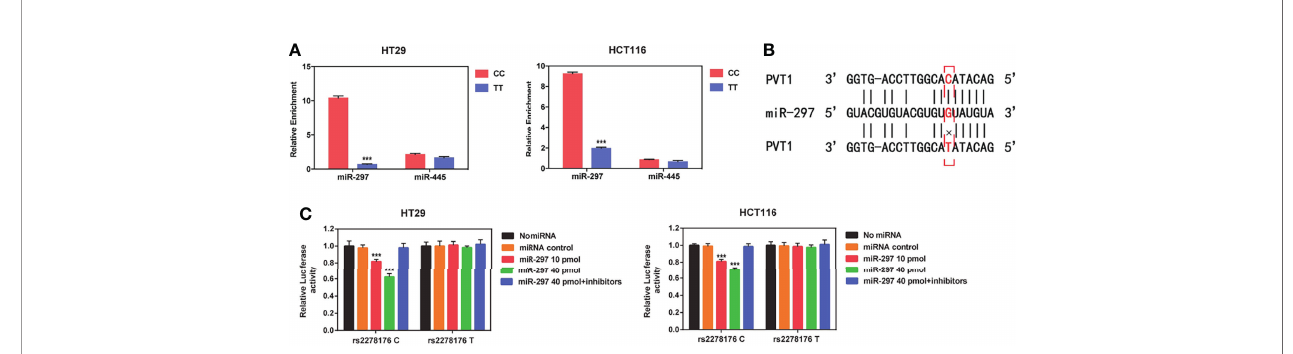
FIGURE 4 | PVT1 rs2278176 T allele alters the binding af fi nity with has-miR-297. (A) Binding af fi nity of hsa-miR-297 and hsa-miR-455 to PVT1 in wild type (CC) and mutant (TT) HT29 and HCT116 cell lines ( n = 3 independent clones in each genotype, *** P < 0.001, compared with the CC genotype cells, two-sided t -tests; error bars: SD). (B) Schematic image of binding interaction between hsa-miR-297 and PVT1 rs2278176 C and T allele. (C) Relative reporter gene activity of psi- CHECK-2-PVT1-C-allele or T-allele construct in wild type HT29 and HCT116 cell lines. ( n = 3 each, *** P < 0.001, compared with the psi-CHECK-2-PVT1-C-allele constructs co-transfected with miRNA control, two-sided t -tests; error bars: SD).